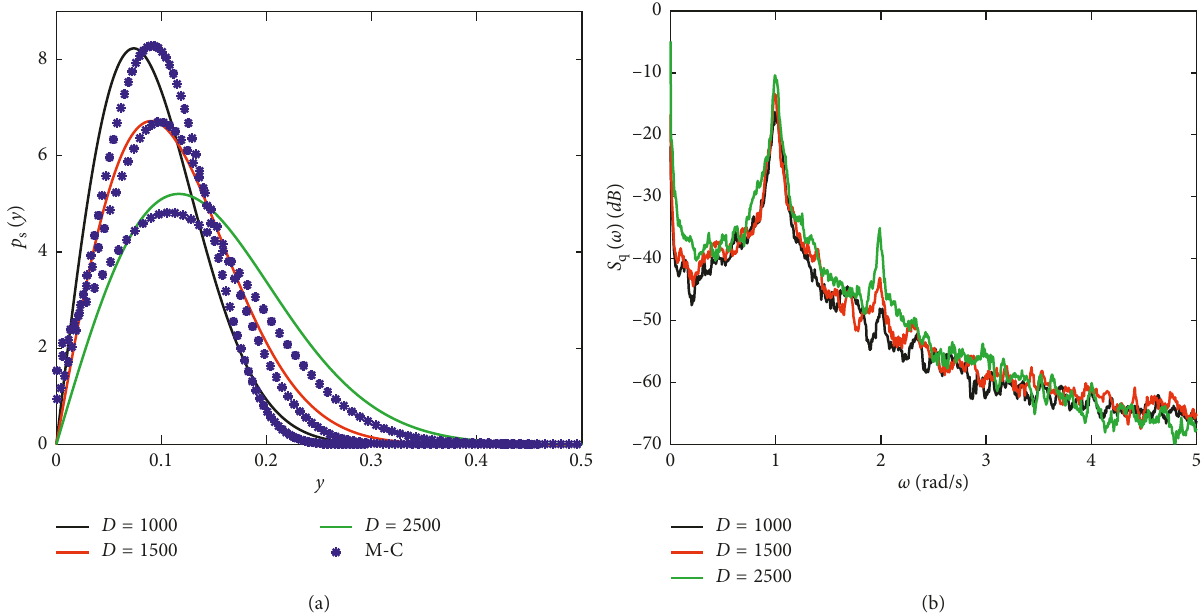
Figure 5: PDF curves of response amplitude and PSD curves of traverse displacement when v � 100m/s.